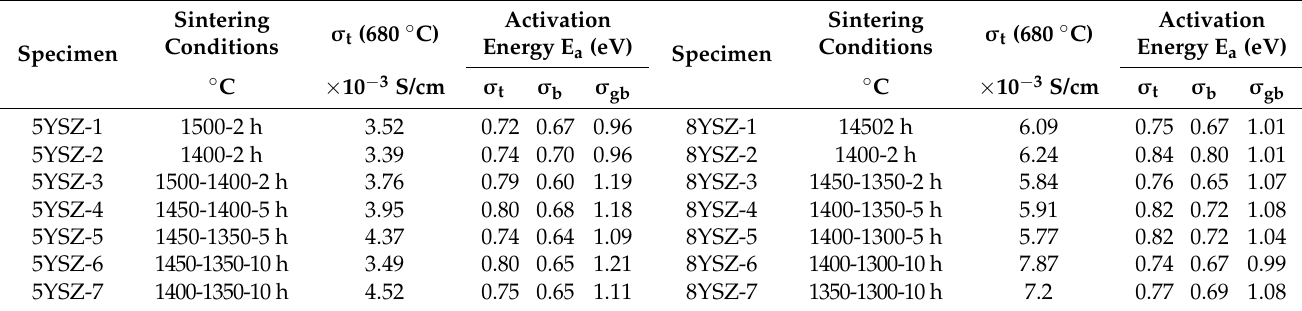
Figure 10. ( a ) Total conductivity, ( b ) grain conductivity, ( c ) grain boundary conductivity of seven 8YSZ ceramics. Table 4. Activation energy of total conductivity of various samples.